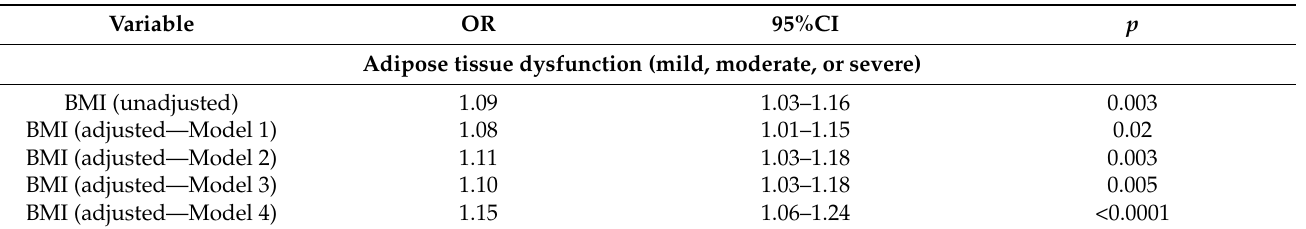
Figure 6. Difference between BMI and BAI receiver-operating characteristics (ROC) curves in identifying VAI-defined adipose tissue dysfunction (ATD): ( A ) no ATD, ( B ) Mild ATD, and ( C ) severe ATD. Table 6. Multivariate logistic regression models to evaluate the associations between adipose tissue dysfunction, BMI, and nutritional status.